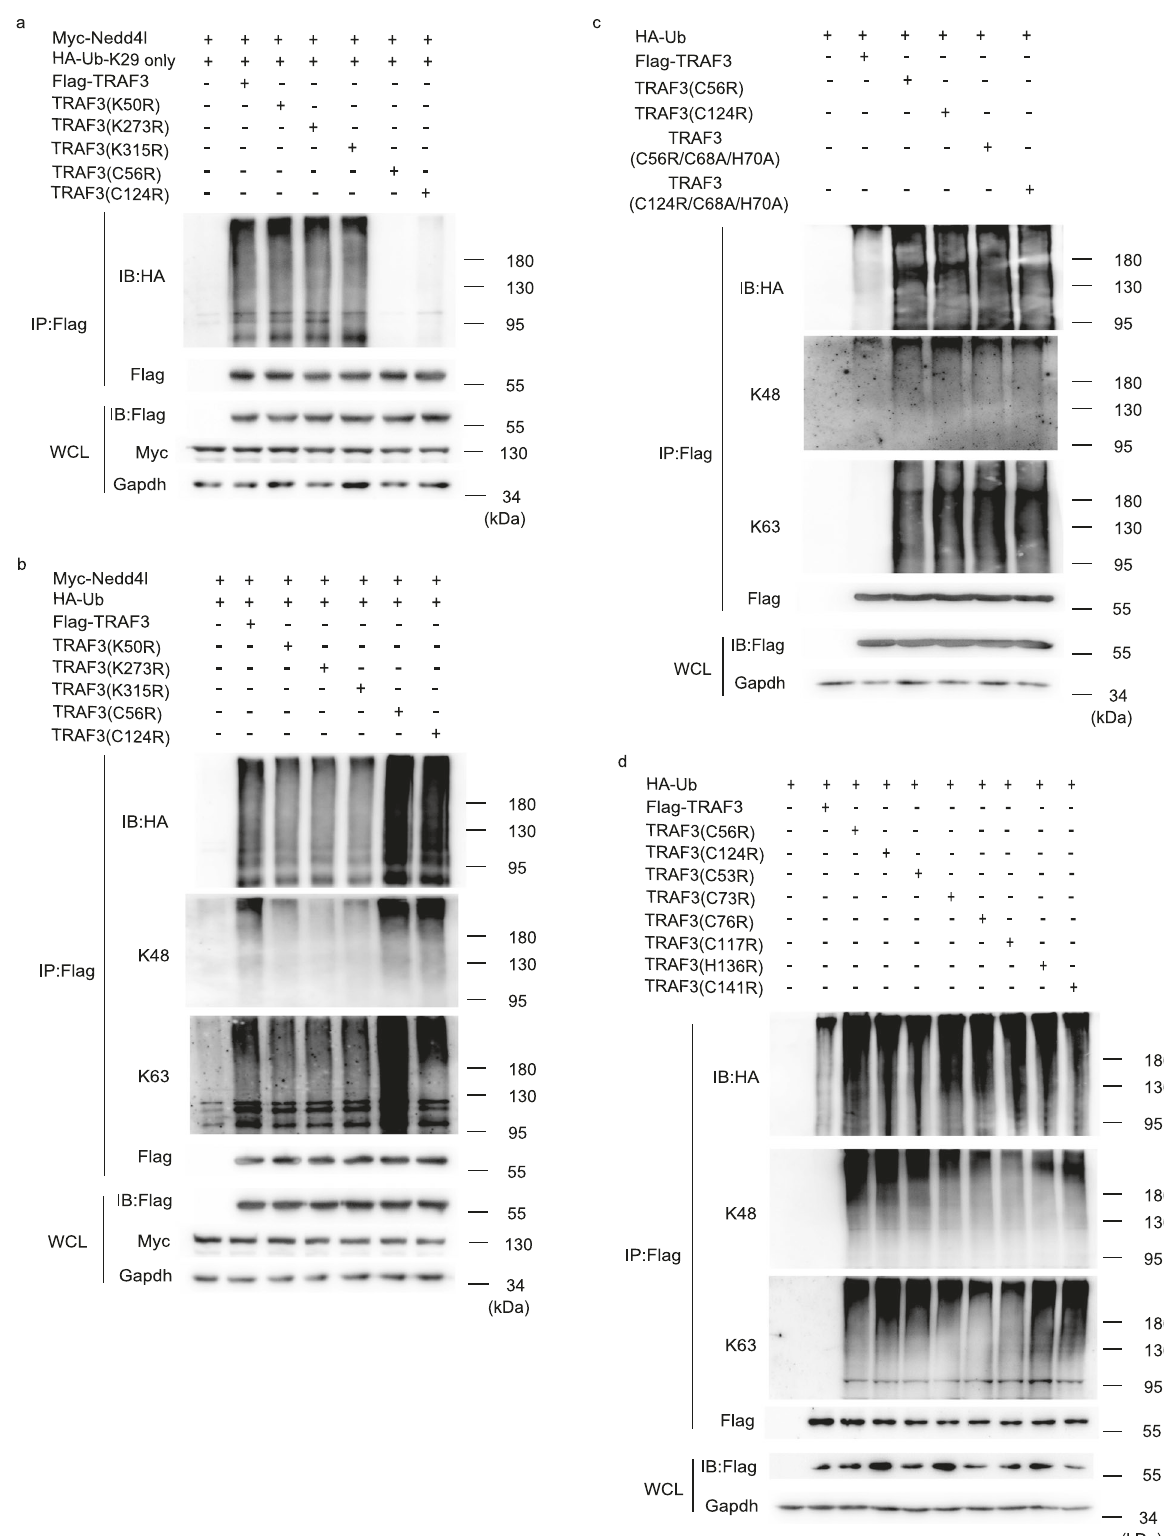
cellular enzyme which converts cholesterol and fatty acid to cho- lesteryl esters, is ubiquitinated on Cys277 by Lys48-linked poly- ubiquitylation for degradation when the lipid level is low, and thus regulates lipid homeostasis 24 . Despite these fi ndings, the physiolo- gical signi fi cance of cysteine ubiquitination is seriously under- estimated. Although lysine ubiquitination in PRR signaling has